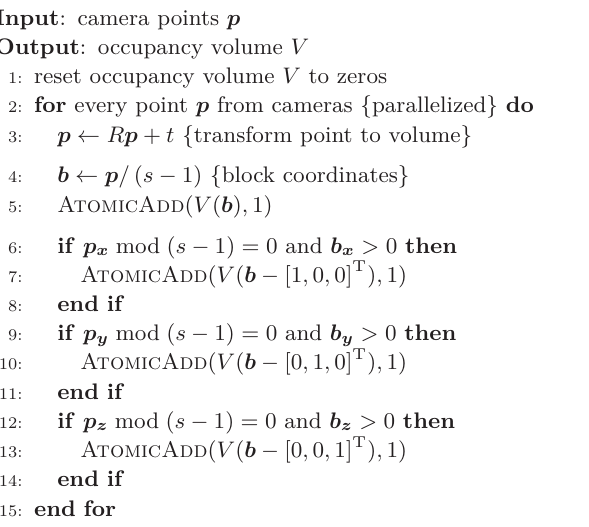
Algorithm 1 Block occupancy calculation